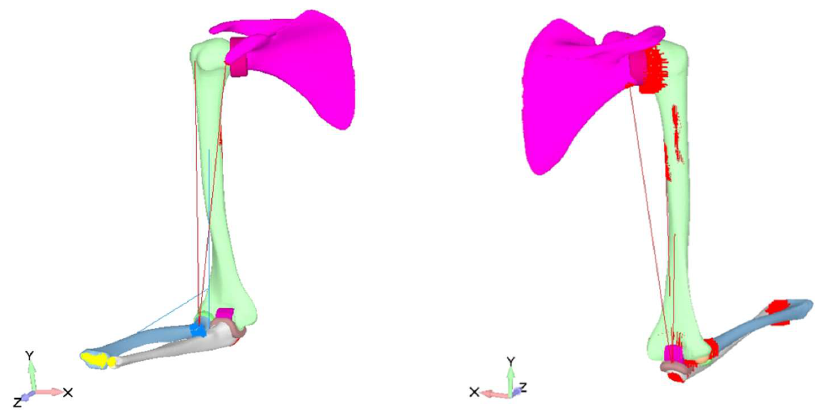
Figure 3. FEA model, biceps study ( left ) and triceps study ( right ), 74° aperture angle.